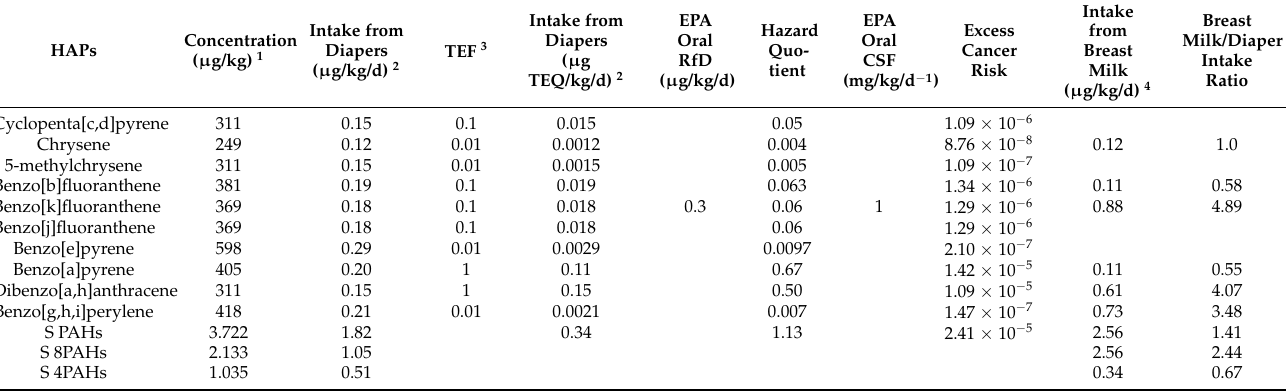
Table 5. Risk assessment of polycyclic aromatic hydrocarbons (PAHs) in diapers with the scenario 2.1 equation incorporating a rewet factor of 1% and comparison of the intake from diapers with that from breast